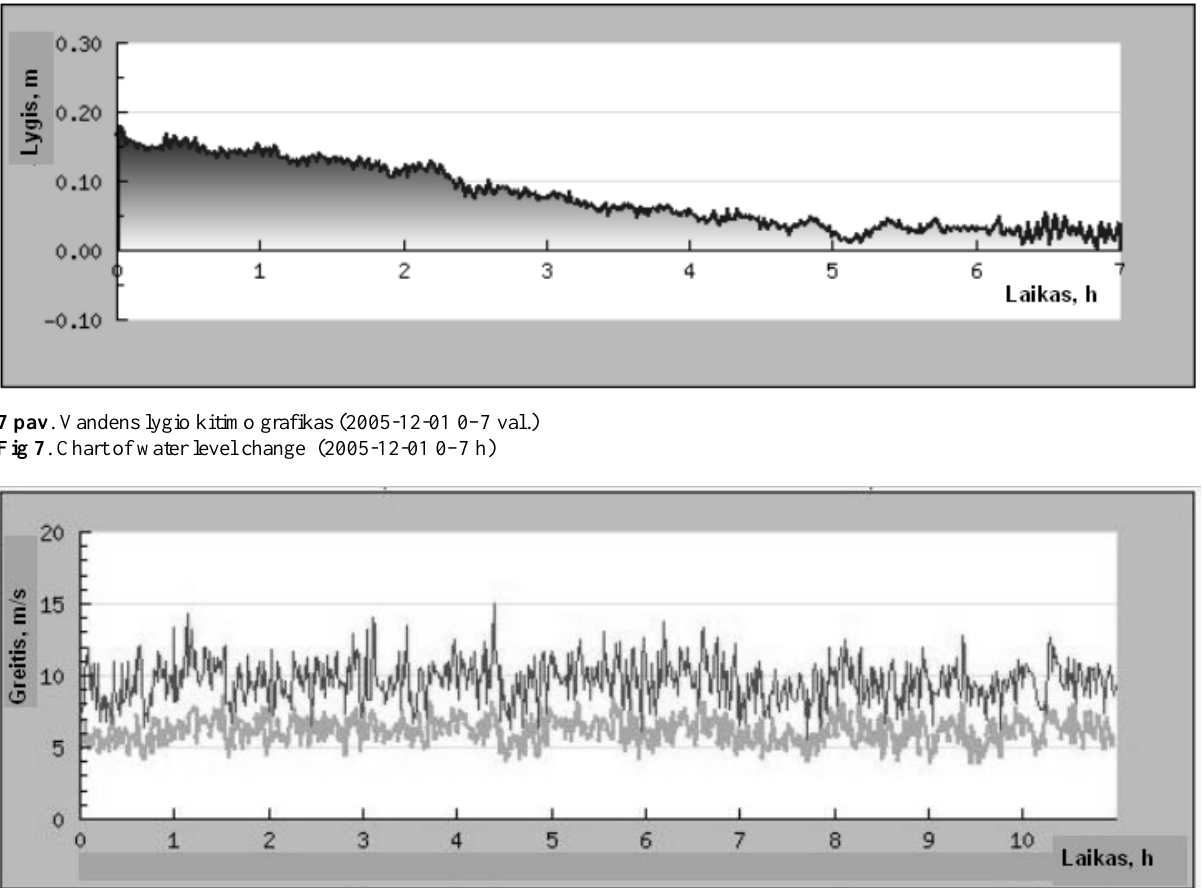
Fig 8 . Chart of wind speed and gust change (2006-09-06 0–11 h)